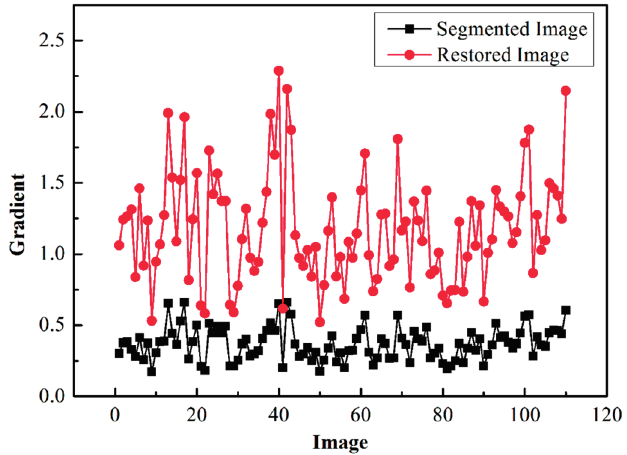
Figure 14. Gradients of the segmented and restored